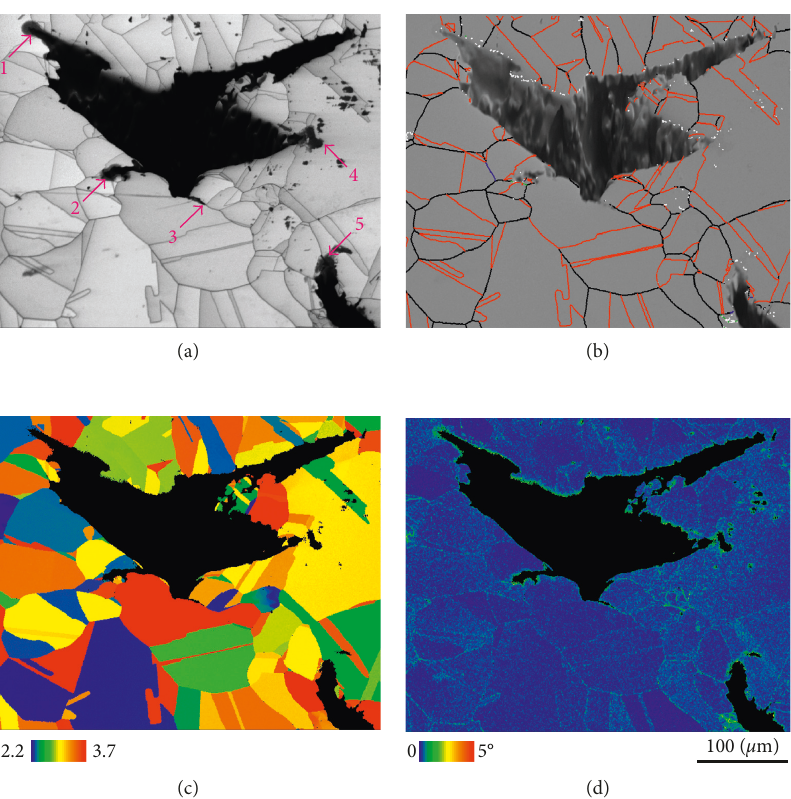
Figure 6: Microstructure of the longitudinal section near the fracture surface of a specimen tensioned at 1050 ° C and 10 − 4 · s − 1 (Region 1). Horizontal direction is the tensile axis. (a) Band contrast image, (b) corresponding SEM map, (c) Taylor factor map, and (d) KAM